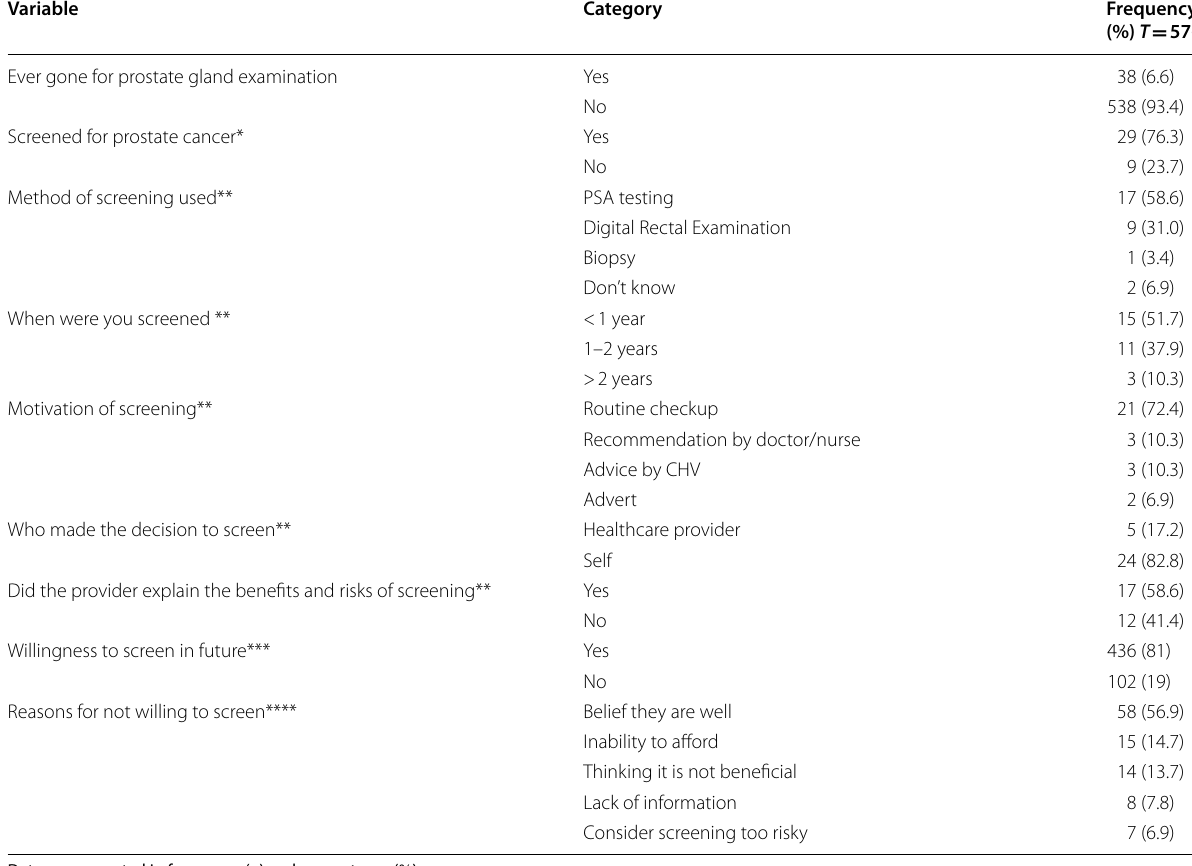
Table 3 Prostate cancer screening